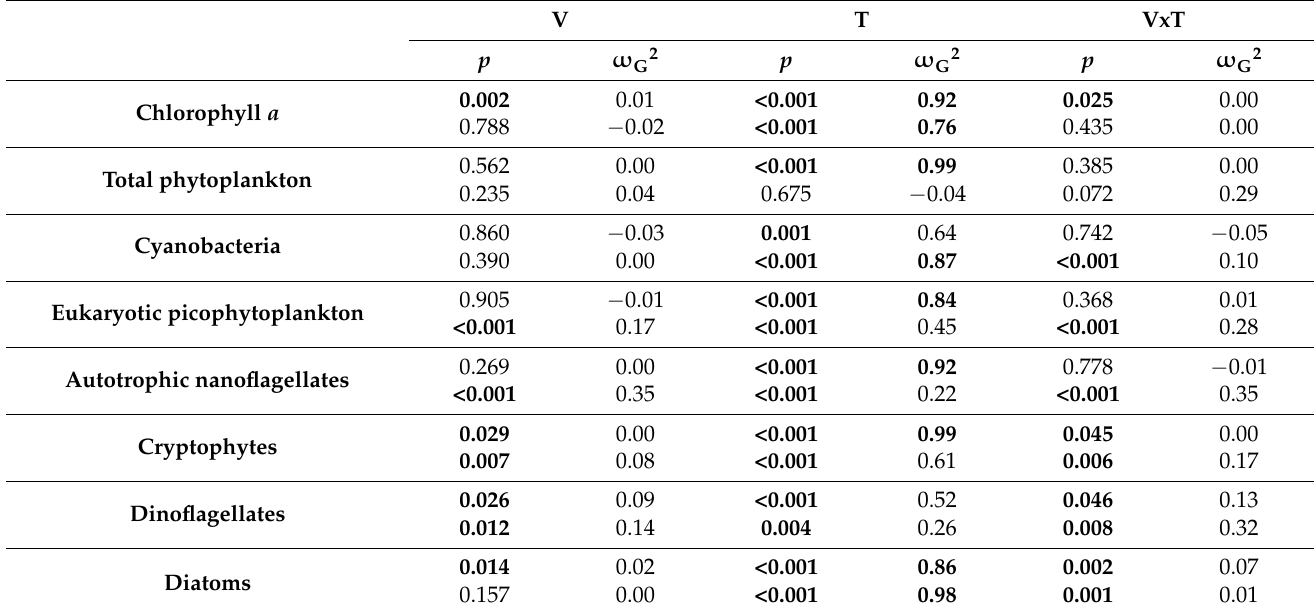
Table 1. Two-way ANOVA output, with p -values ( p ) and generalized partial omega-squared effect size values ( ω G2 ) for the effects of experimental volume (V), experimental duration (T), and interactions between the two variables (VxT), on net growth rates of the phytoplankton community, expressed as changes in chlorophyll a concentration (Chl-a), and in the abundance of the phytoplankton assemblage (total phytoplankton) and of specific phytoplankton groups, for the two experiments (the first line of each group is the autumn experiment, and the second line is the summer experiment). Significant differences ( p < 0.05) and large effect sizes ( ω G2 > 0.07) are represented in bold. V